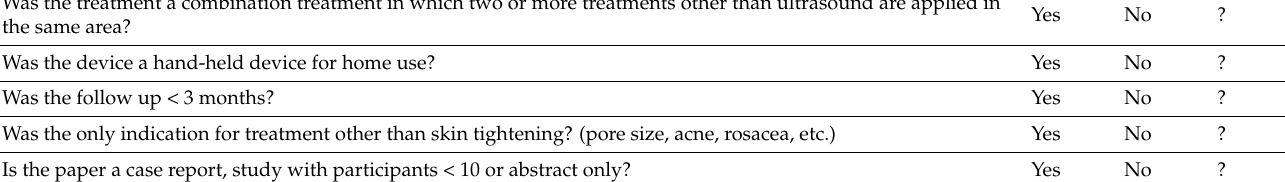
Table A2. Exclusion criteria.